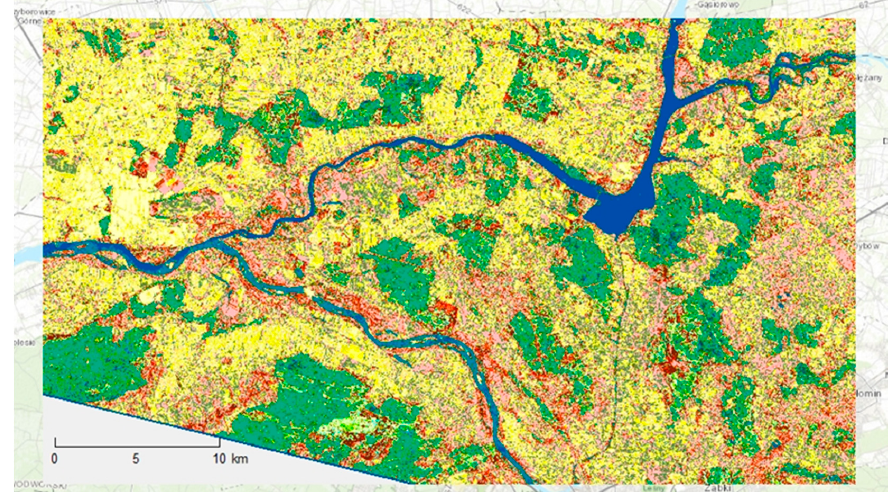
Figure 5. Visualization of a single band, pseudo color and manually clustered (of adjacent values) image of the transformed and rescaled outcome of the RS algorithm application on an original Landsat ETM+ satellite image, involving information from all nine spectral band components. The colors are similar to the CLC legend. Displayed as a layer on top of a topographic map.